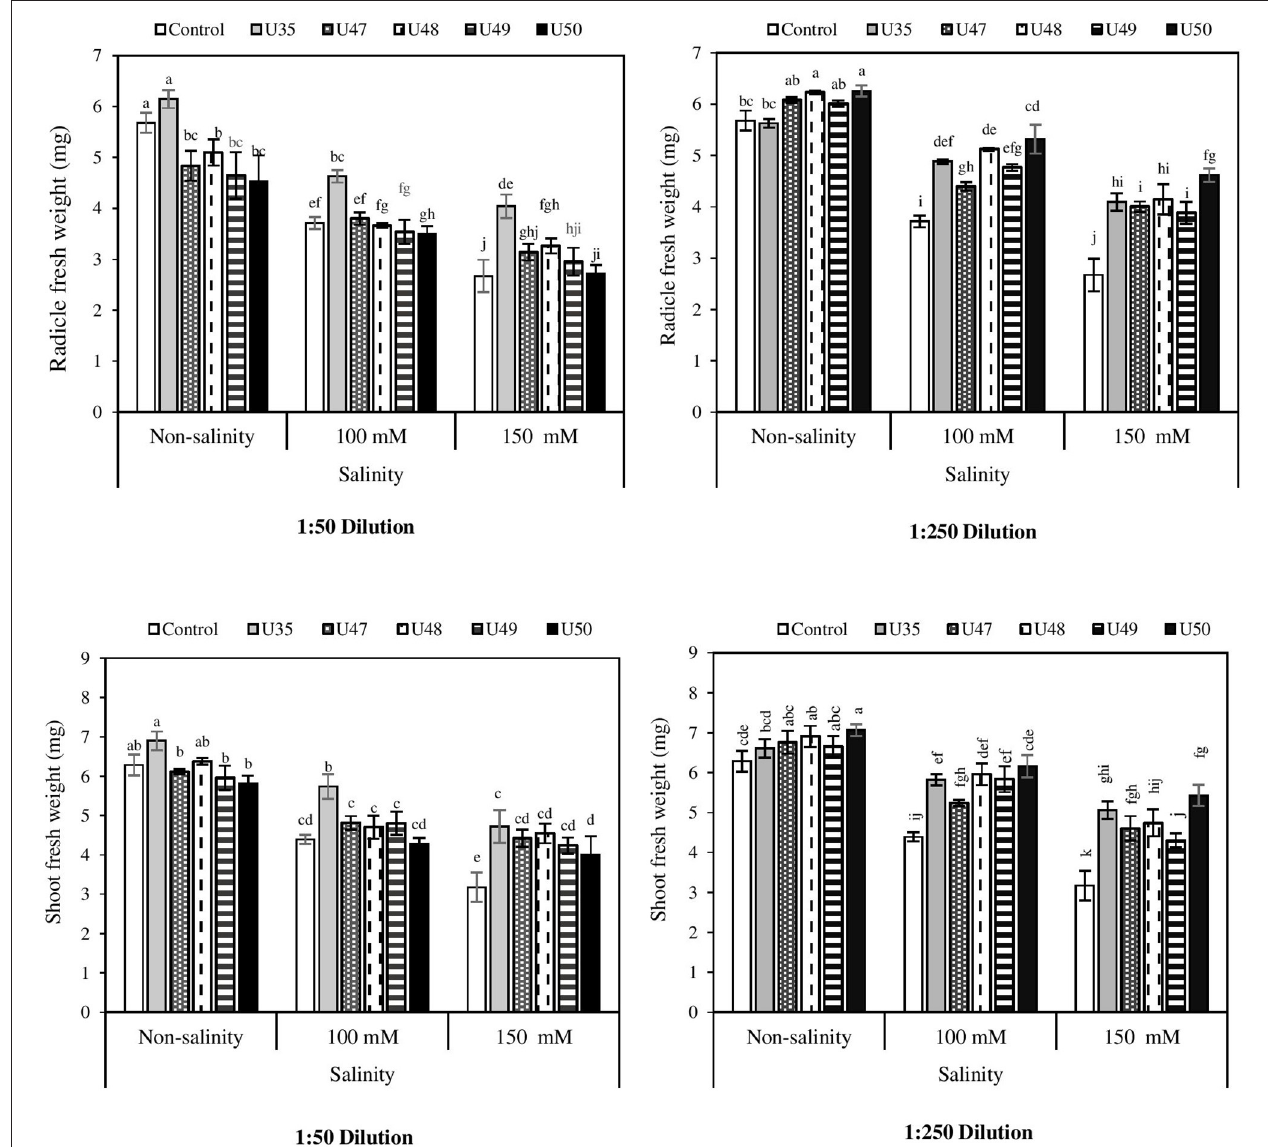
FIGURE 2 | Effect of 1:50 and 1:250 dilutions of Bacillus strain CFSs (U35, 47, 48, 49, and 50) and salinity on radicle and shoot fresh weight of corn seedlings. Values represent the mean of five replicates ± SD. 1:50 = 1mL Bacillus strain CFSs and 50mL distilled water and 1:250 = 1mL Bacillus strain CFSs and 250mL distilled